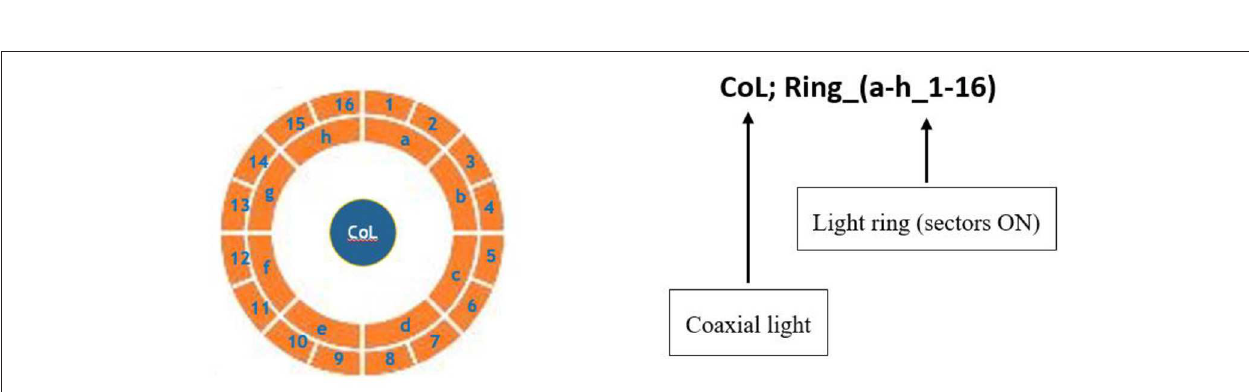
FIGURE 2 | Markings of individual light sectors of the